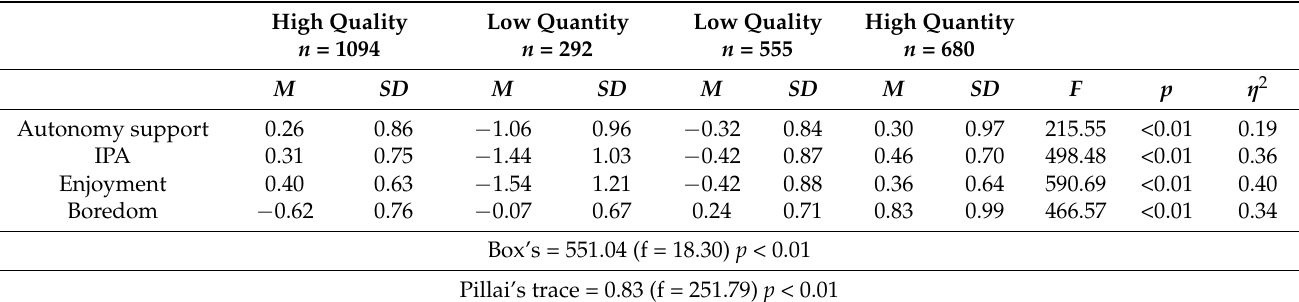
Table 3. Differences in autonomy support, intention to be physically active, enjoyment and boredom according to the motivational